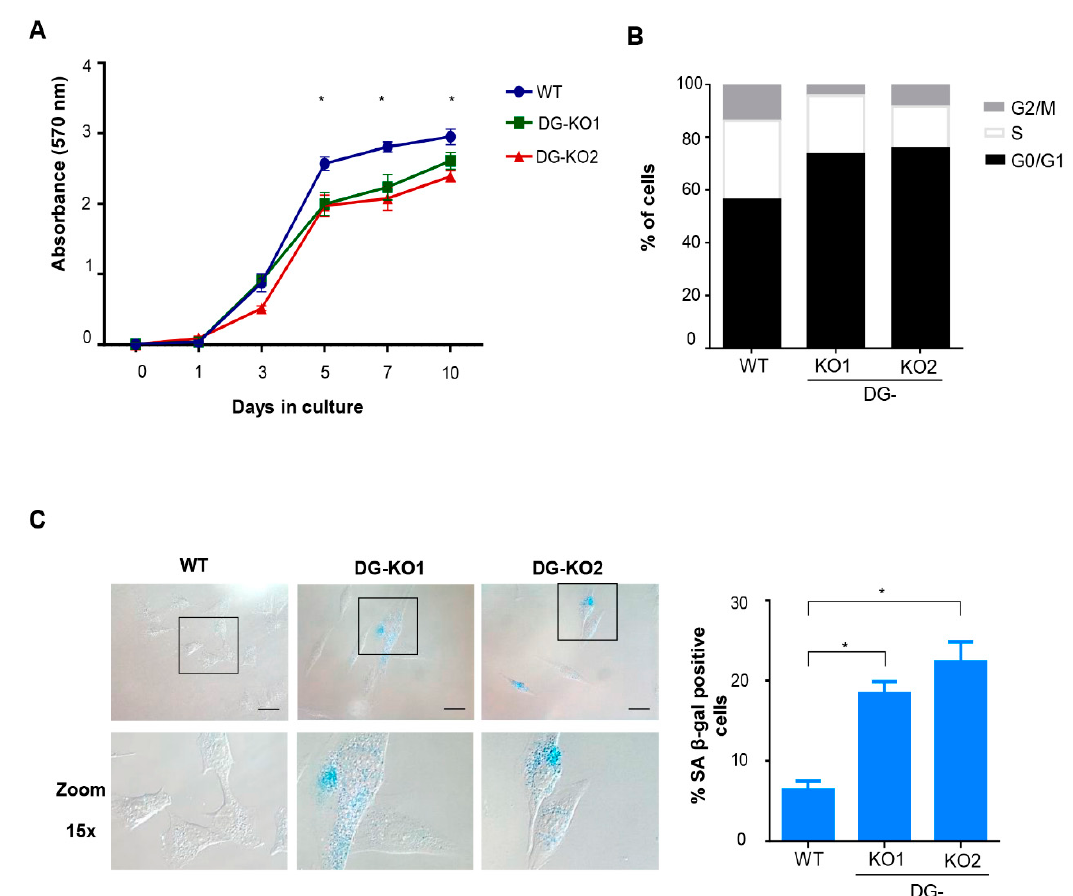
Figure 4. DG-KO cell cultures exhibit decreased proliferation, G0 / G1 arrest and senescence. ( A ) MTT-based cell proliferation assays were performed over a 10 days period in WT, DG-KO1 and DG-KO2 cell cultures. Data correspond to the mean ± SEM from three independent experiments, with significant di ff erences determined by one-way ANOVA; * p < 0.05 compared to WT. ( B ) Cell cycle analysis on WT, DG-KO1 and DG-KO2 asynchronous cell cultures was performed by flow cytometry. A typical graph from three independent experiments is shown. ( C ) Senescent cells were identified in WT, DG-KO1 and DG-KO2 cultures by quantifying SA β -gal activity, and representative images were acquired by light-field microscopy. Bar = 50 µ M. Right: the percentage of senescent cells was calculated, and significant di ff erences were obtained from three separate experiments using one-way ANOVA, followed by Dunnett´s post hoc test. Data correspond to the mean ± SEM ( n = 200 cells for each cell culture; * p < 0.05 compared to WT).